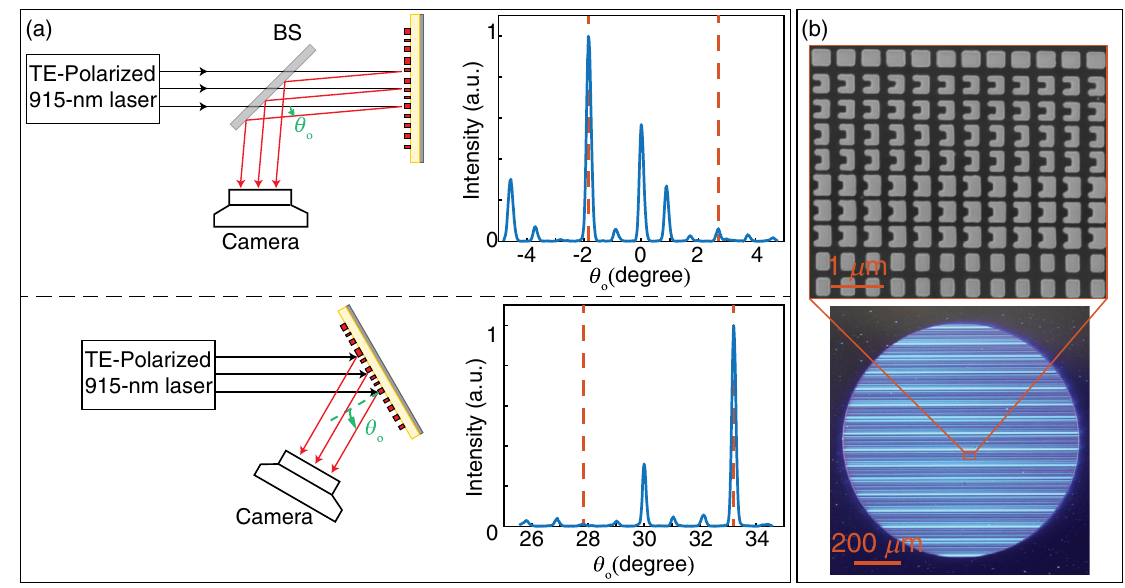
FIG. 3. Angle-multiplexed grating. (a) Simplified schematic of the measurement setup (left) and measured reflectance of the angle- multiplexed grating under normal illumination of TE-polarized light as a function of the observation angle θ 0 (right). The grating deflects 0° and 30° TE-polarized incident light to − 1 . 85 ° and þ 33 . 2 °, respectively. Orange dashed lines indicate the designed deflection angles ( − 1 . 85 ° and þ 33 . 2 ° under 0° and 30° incidence, respectively) and the deflection angles corresponding to regular gratings with fixed grating periods (2.7° under normal and 27.88° under 30° illumination angles assuming grating periods of 21 λ and 31 λ , respectively). See Appendix B and Ref. [63] (Fig. 2) for measurement details. (b) Optical image of the angle-multiplexed grating. The inset shows a scanning electron micrograph of the top view of meta-atoms composing the metasurface. See Appendix B for fabrication details. BS is for beam